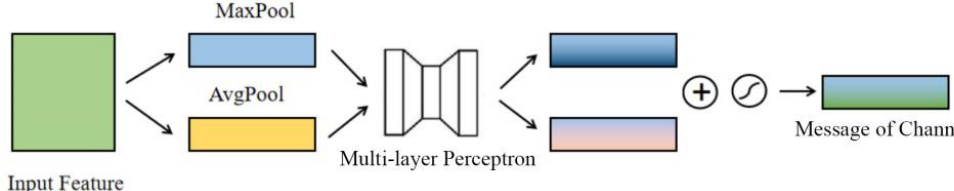
Figure 13. Schematic diagram of channel attention module.